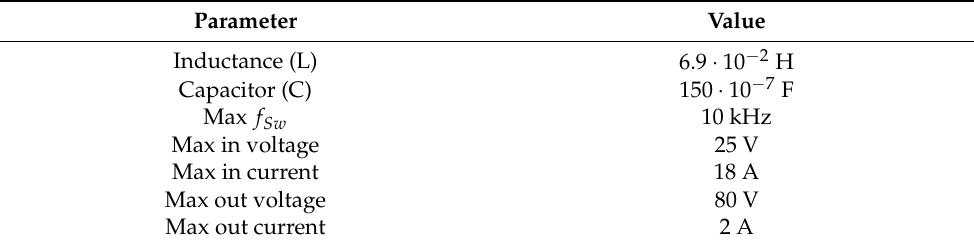
Table 3. DC/DC boost converter